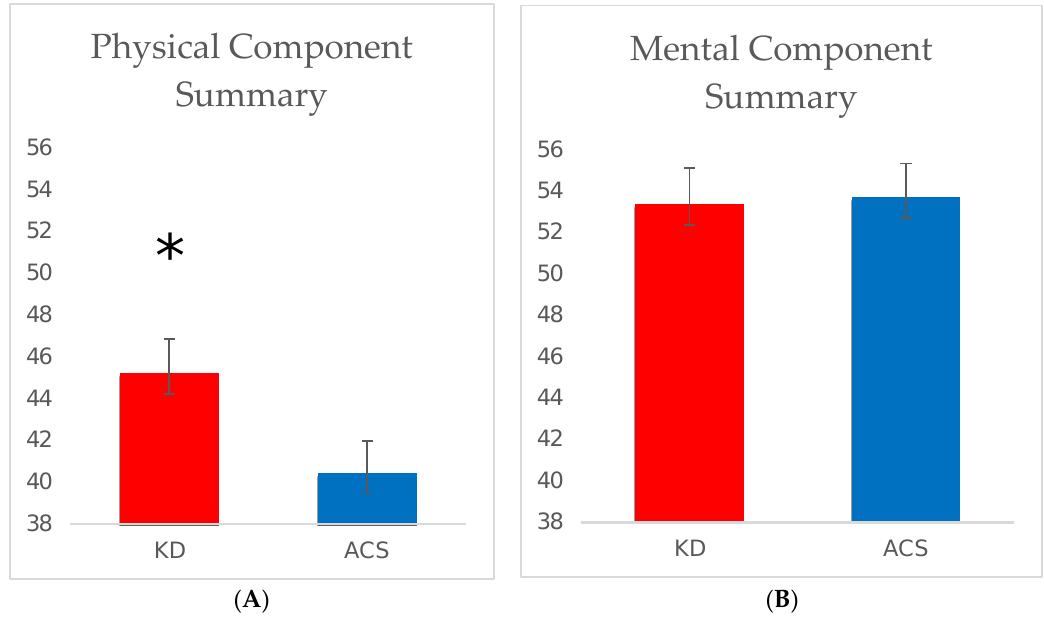
Figure 1. ( A ) Physical component summary scores at 12 weeks by diet group and ( B ) mental component summary at 12 weeks. Values are adjusted means ± SEM. * Denotes a significant between-group difference ( p < 0.05) from ACS arm by ANCOVA, using baseline values and chemotherapy status as covariates. ACS, n = 20; KD, n = 23.